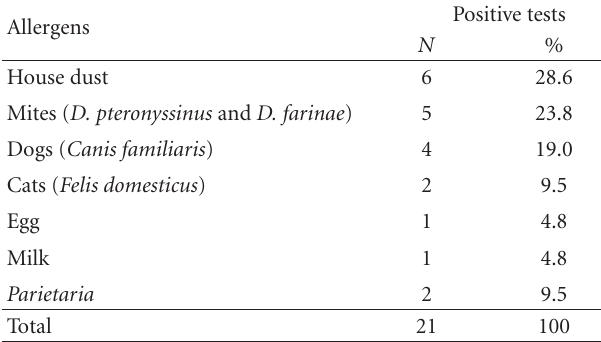
Table 4: Positive RAST (and skin prick test when performed) to various aeroallergens and food allergens in persistent allergic rhini-